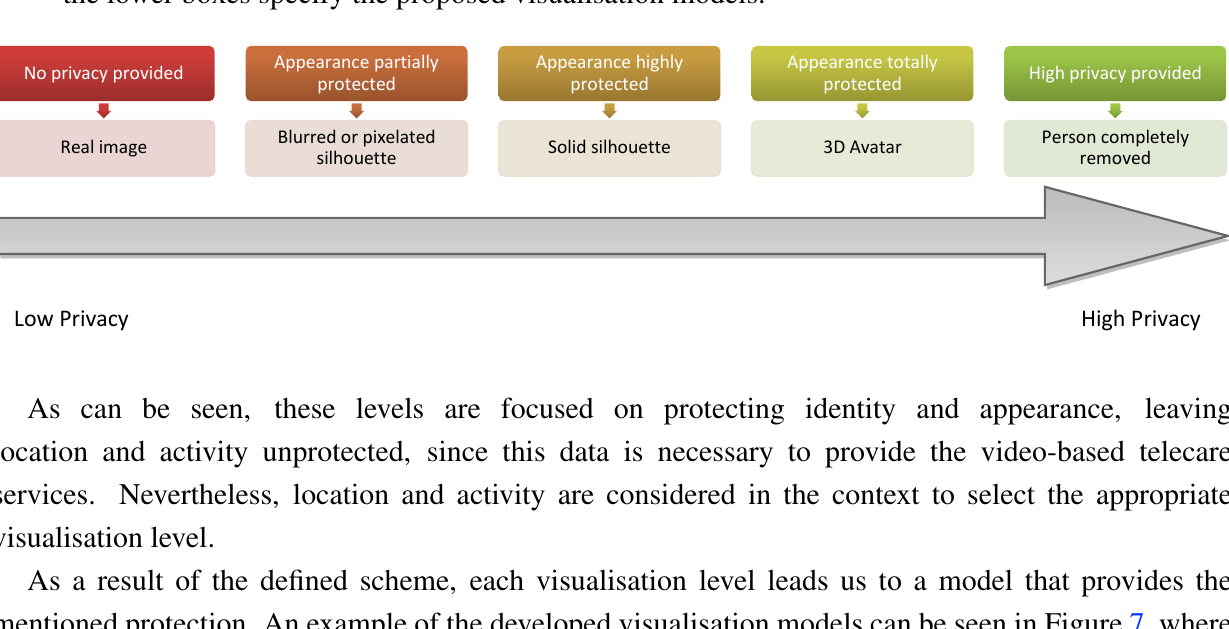
Figure 6. Specific visualisation levels that have been defined to apply the proposed privacy scheme to the vision@home project. The upper boxes indicate the protection level, whereas the lower boxes specify the proposed visualisation